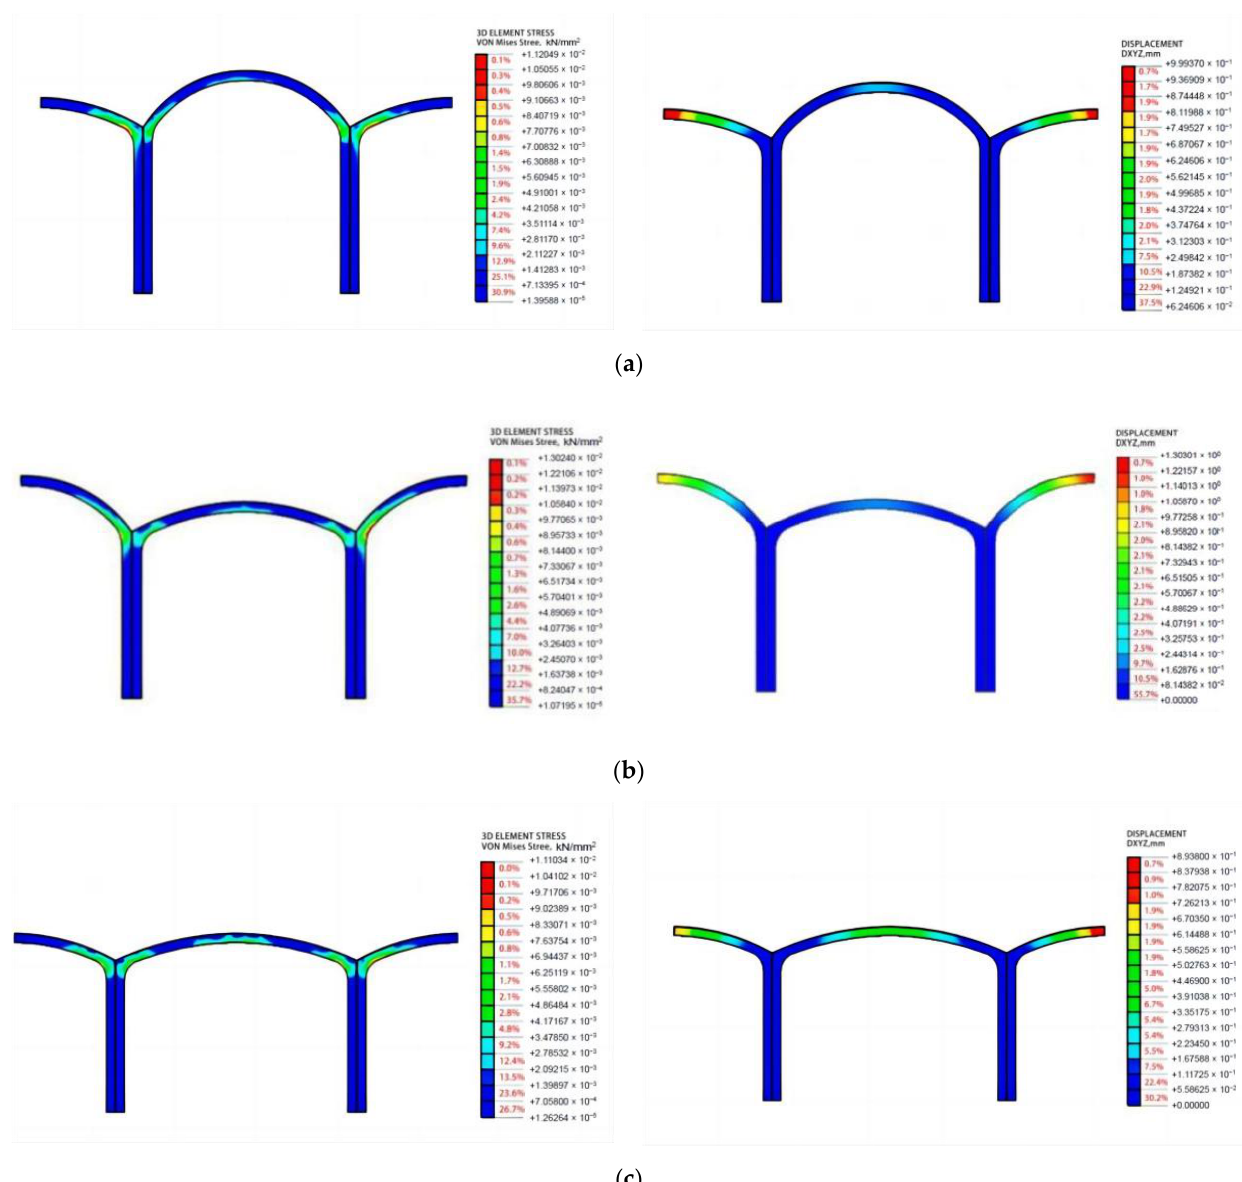
Figure 12. Stress distributions and displacement results of three rigid frames with variable parameters. ( a ) Rigid frame with the same span, different heights, and taller internal cantilevers; ( b ) Rigid frame with the same span, different heights, and taller external cantilevers; ( c ) Rigid frame with the same height, different spans, and longer internal cantilevers.